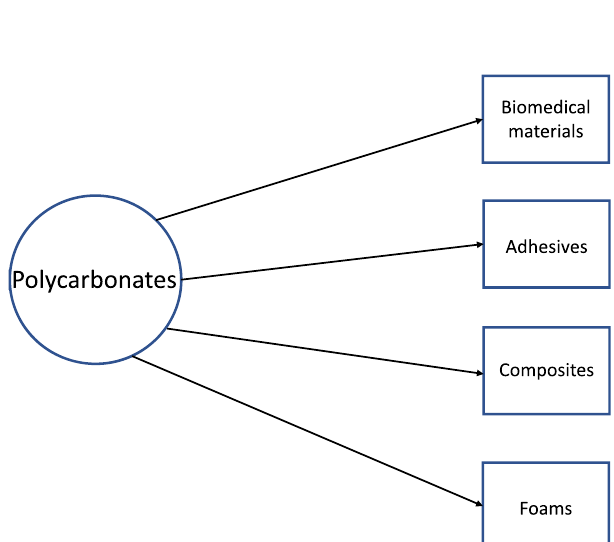
Fig. 1. Main effects of CO 2 emissions.